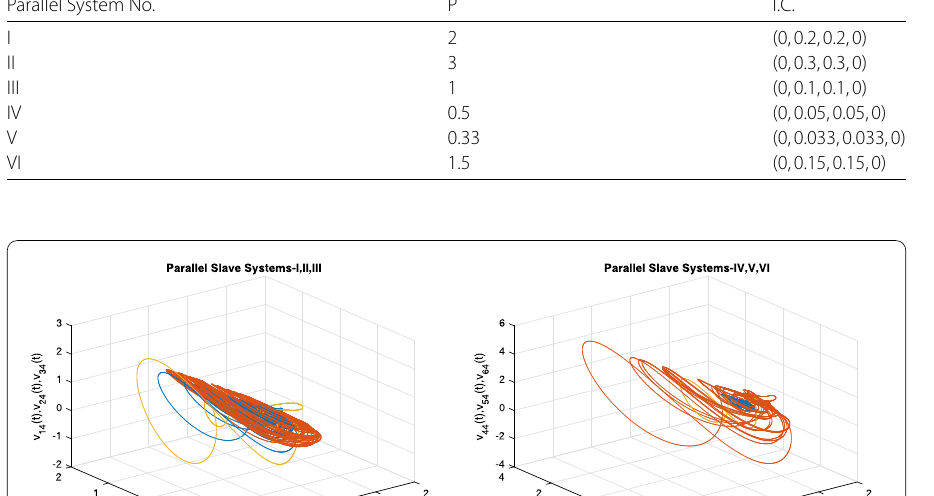
Table 2 Parallel systems for a = 0.2, b = 1 and q = 0.95 Parallel System No.